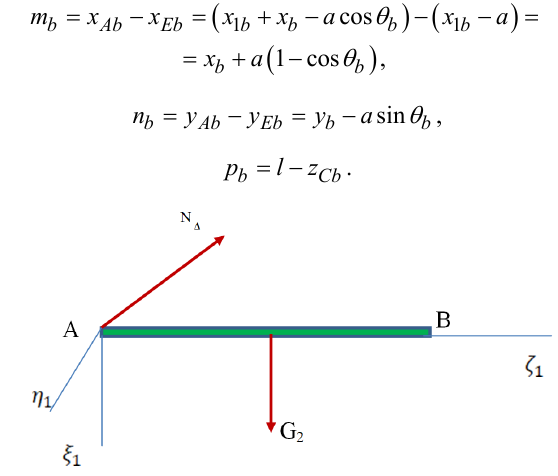
Figure 12. Calculation diagram for the rope tension N A